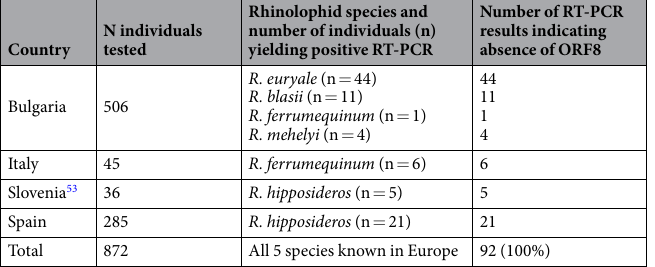
Table 1. Bat specimens included in this study and confirmation of absence of ORF8. Absence of ORF8 was determined by RT-PCR using reverse primers F29260R (TTTGTATGCGTCAATGTGCTTG) for